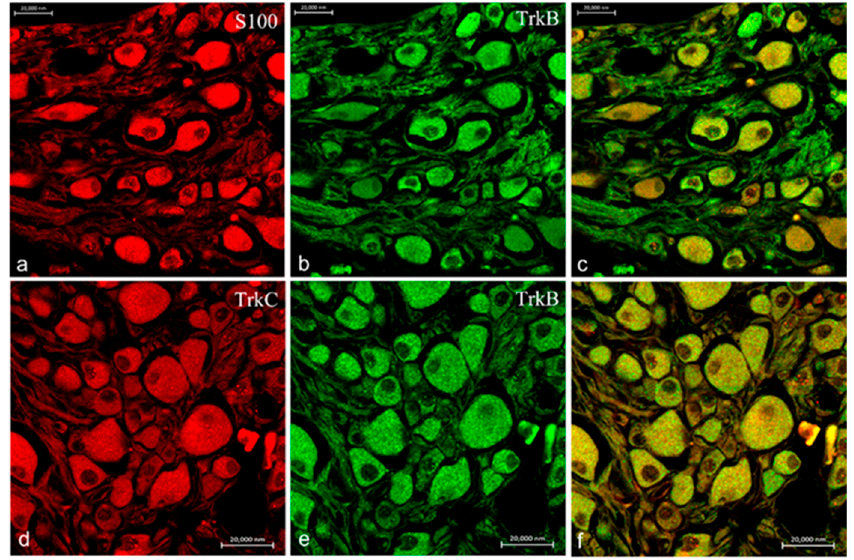
Figure 9. Ganglia of the VIII cranial nerve of N. guentheri head; transversal view. Immunohistochemical detection (immunofluorescence method) of TrkB, TrkC, and S100 protein. Immunoreactivity displayed to TrkB ( b,e ), TrkC ( d ), and S100 ( a ). Colocalization view ( c,f ). Magnification 40x.